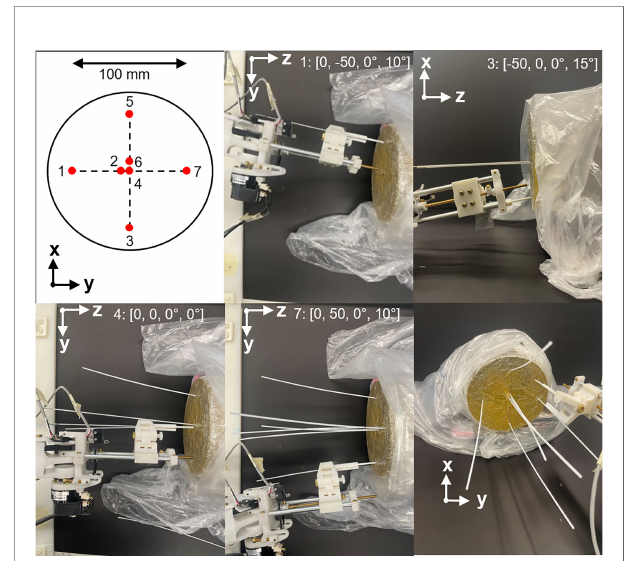
FIGURE 9 | Example of multiple needle insertion by the robot using a gel phantom. Top left: needle insertion plan with numbers indicating order of insertion. In order from top-middle to bottom middle: photographs showing needle insertions at needles 1, 3, 4 and 7. Axis indicators show the perspective of each photograph. Insertion points and insertion angles are shown in each photograph as [ X, Y, R x , R y ]. Bottom right: isometric view after insertion of all